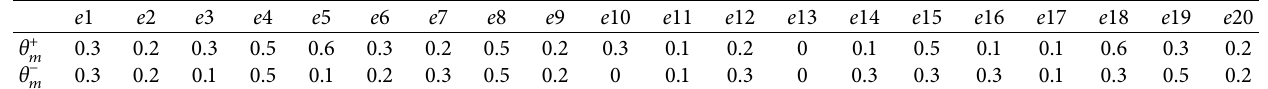
− m and θ m for each DM provided.